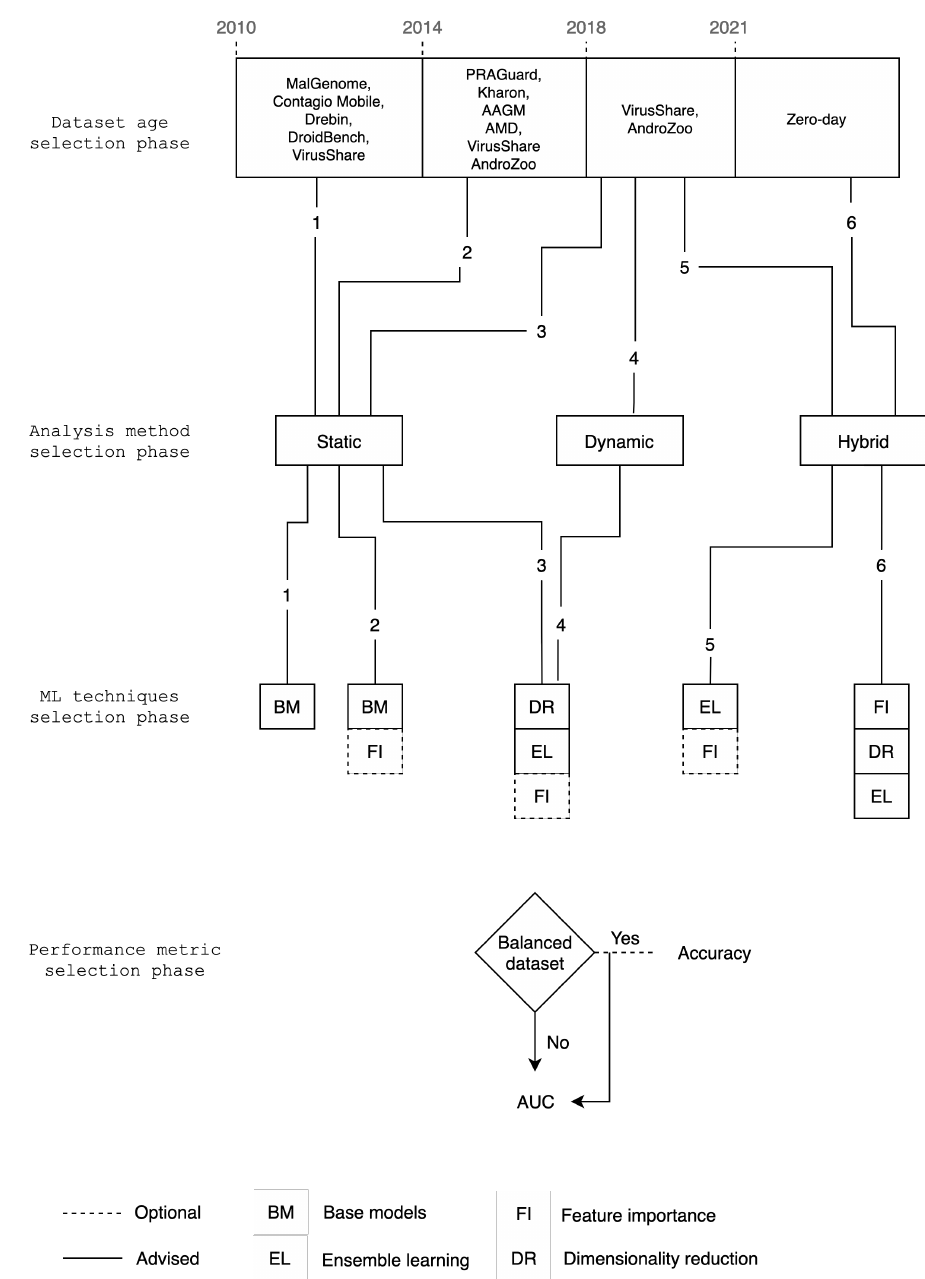
Figure 2. Baseline scheme for mobile malware detection